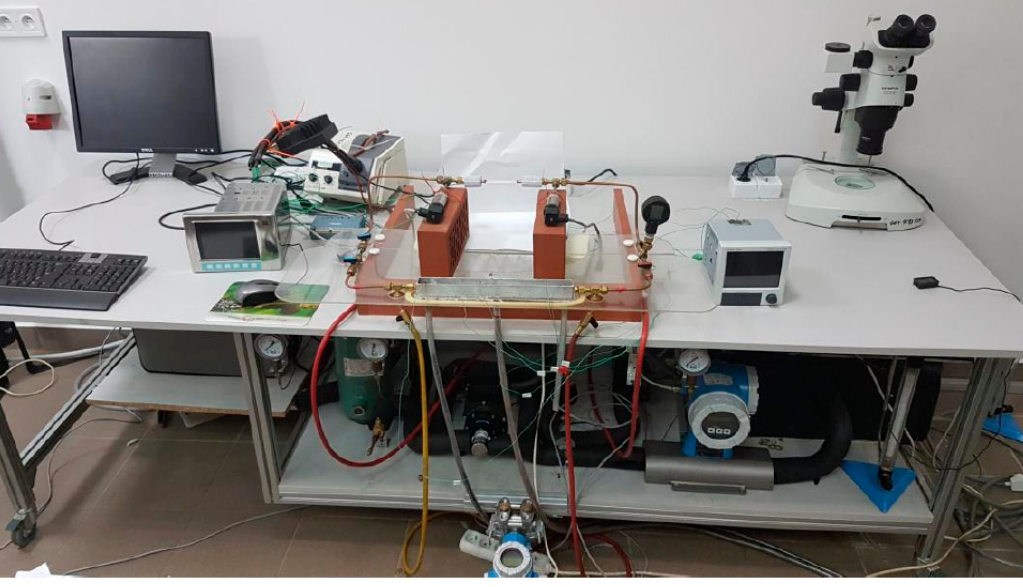
Figure 2. View of test stand.